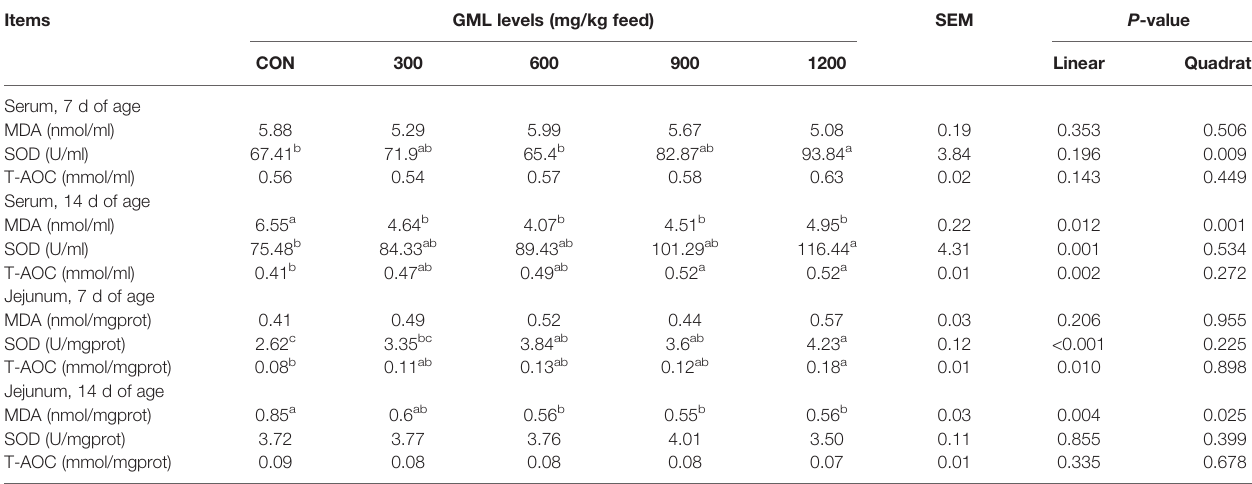
TABLE 7 | Effects of dietary treatment on antioxidant capacity in 7- and 14-day-old broilers.